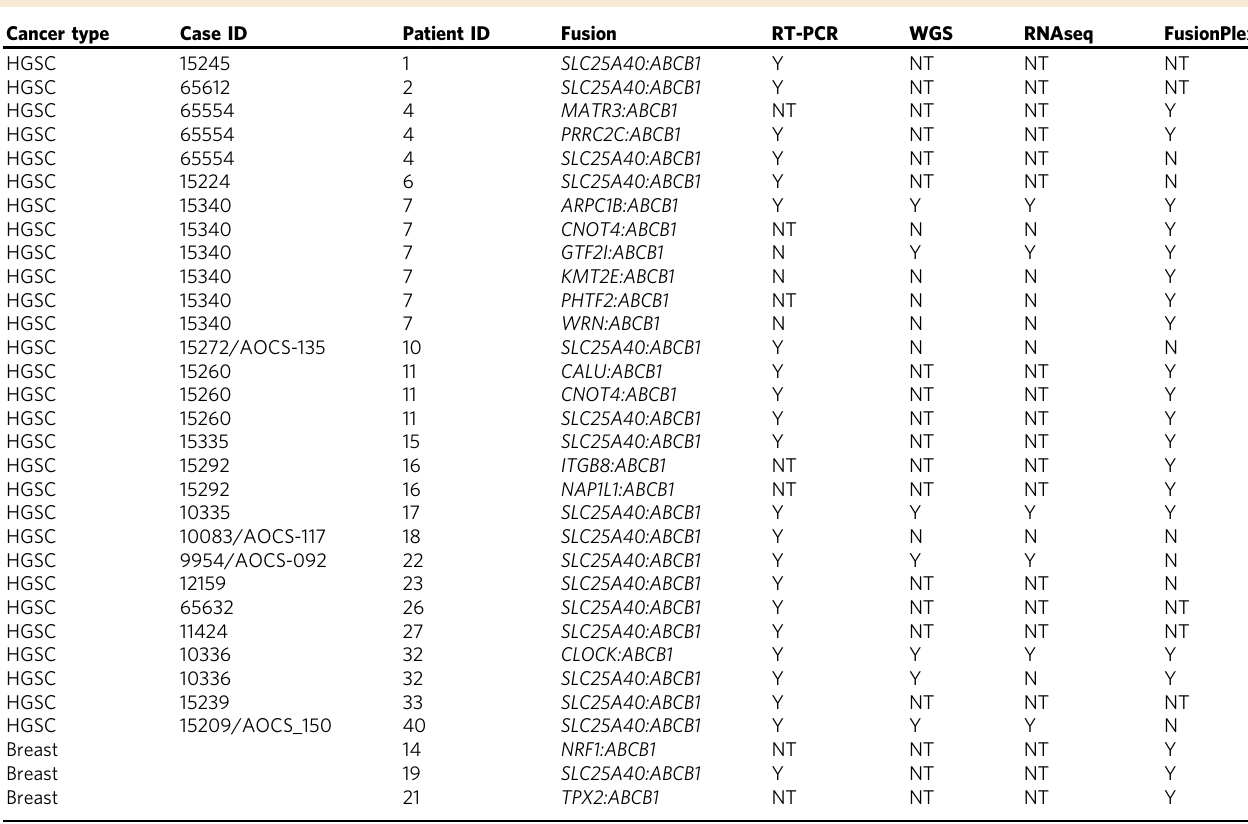
Table 2 Details of ABCB1 transcriptional fusions Cancer